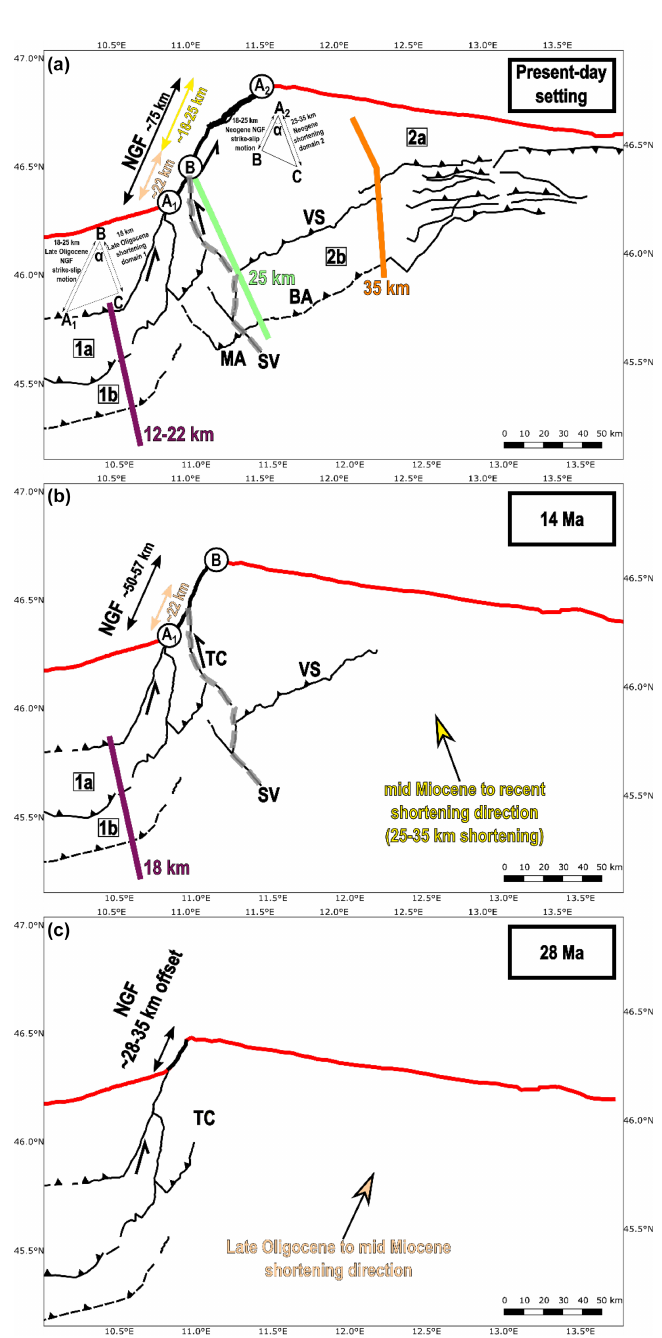
Figure 14. Kinematic evolution of the eastern Southern Alps from the present day (a) to Late Oligocene time (c) . (a) Present configuration of the eastern Southern Alps with ∼ 75km sinistral offset of the PF along the NGF. There are two kinematic contributions to the ∼ 75km of strike-slip motion: (1) 25–35km of Middle Miocene NNW–SSE shortening across kinematic domain 1 and 2 (Fig. 12), which when projected onto the NGF, corresponds to ∼ 18–25km of sinistral strike-slip (displacement vector triangle A 2 BC ), and (2) 18km of Chattian to Middle Miocene, NNE–SSW to NNW–SSE shortening west of the TC-SV fault system, which when projected onto the NGF corresponds to ∼ 22km of sinistral strike-slip (see discussion in Sect. 3). (b) At ∼ 14Ma the NGF sinistrally displaced the PF by ∼ 50–57km (both minimum values). Since the Middle Miocene ( ≥ 14Ma), ∼ 20–35km of shortening both east and west of the TC-SV fault system were transferred to motion along the NGF at ≥ 14Ma which is therefore at this time only displaced by 50–57km. The minimum ∼ 50–57km offset along the NGF at ∼ 14Ma is partly attributable to a minimum 18km of Late Oligocene to Middle Miocene shortening along the Val Trompia-Giudicarie Belt (“kinematic step 1” of Picotti et al., 1995). (c) At ∼ 28Ma the Periadriatic Fault was only modestly offset ( ∼ 28–35km). If one assumes a mean value within this range of offsets, the PF restores to a relatively straight fault showing only a minor bend north of the Adamello